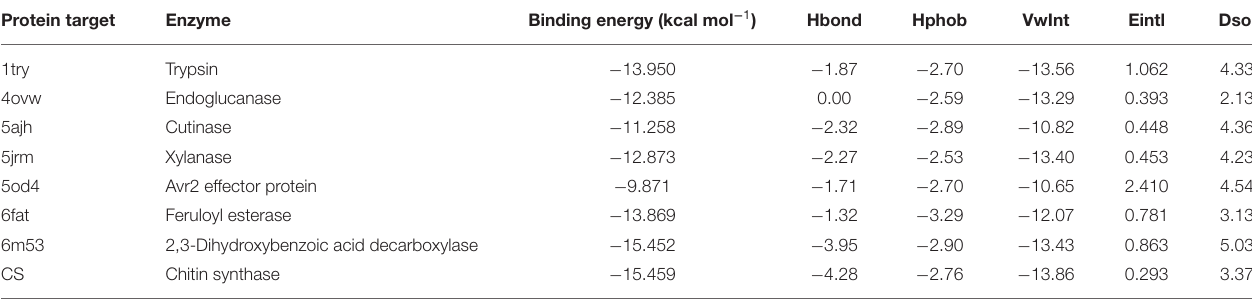
TABLE 4 | Molecular docking results of AITC and the Fusarium oxysporum target proteins studied in silico . Protein target